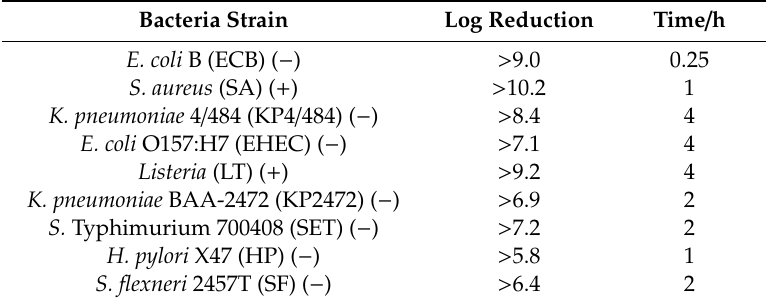
Table 2. Antimicrobial activity of the Cu x Fe y O z NPs (bacterial cells were suspended in 1X PBS). Bacteria Strain